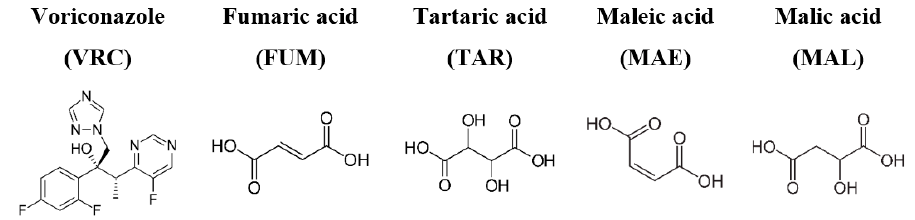
Figure 1. Chemical structures of voriconazole (VRC) and the chosen C4 diacid